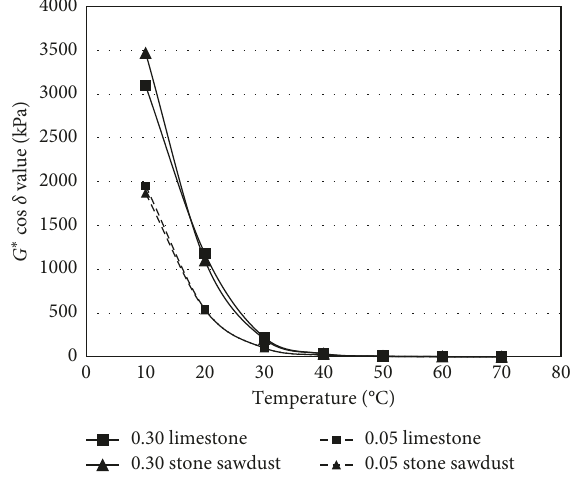
Figure 12: limestone